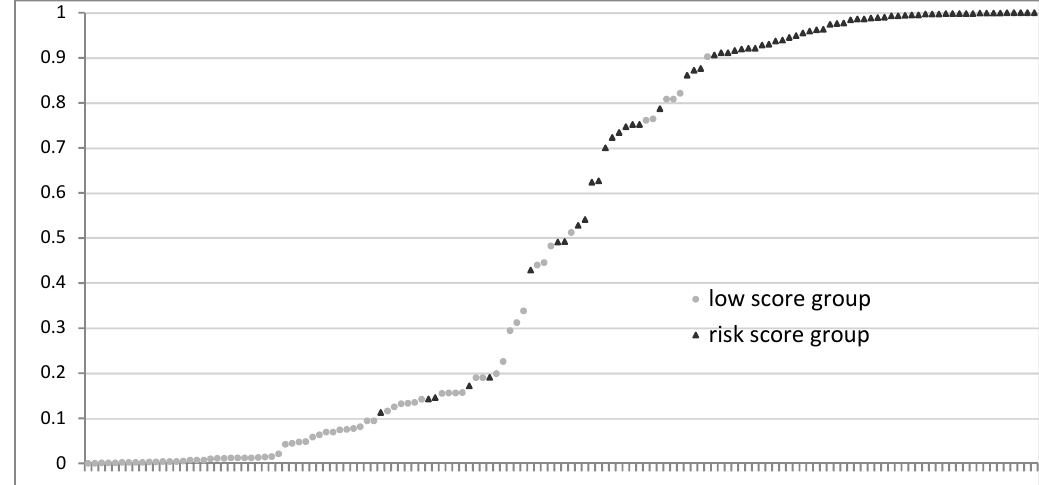
Figure 1. Observed groups and probability prediction.